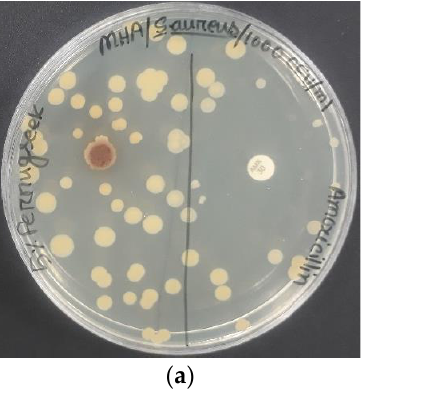
Figure 13. Antimicrobial analysis of the bio-composite samples at various ratio of fenugreek ( a ) 5%, ( b ) 10%, and ( c ) 15%.